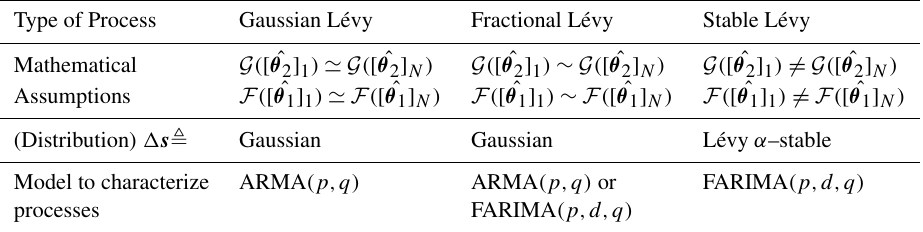
Table 1. Assumptions on the functional model and the stochastic parameters estimated via N iterations (see N -step method) to characterize the type of Lévy processes within the geodetic time series. The symbols and notations are explained in Sect.